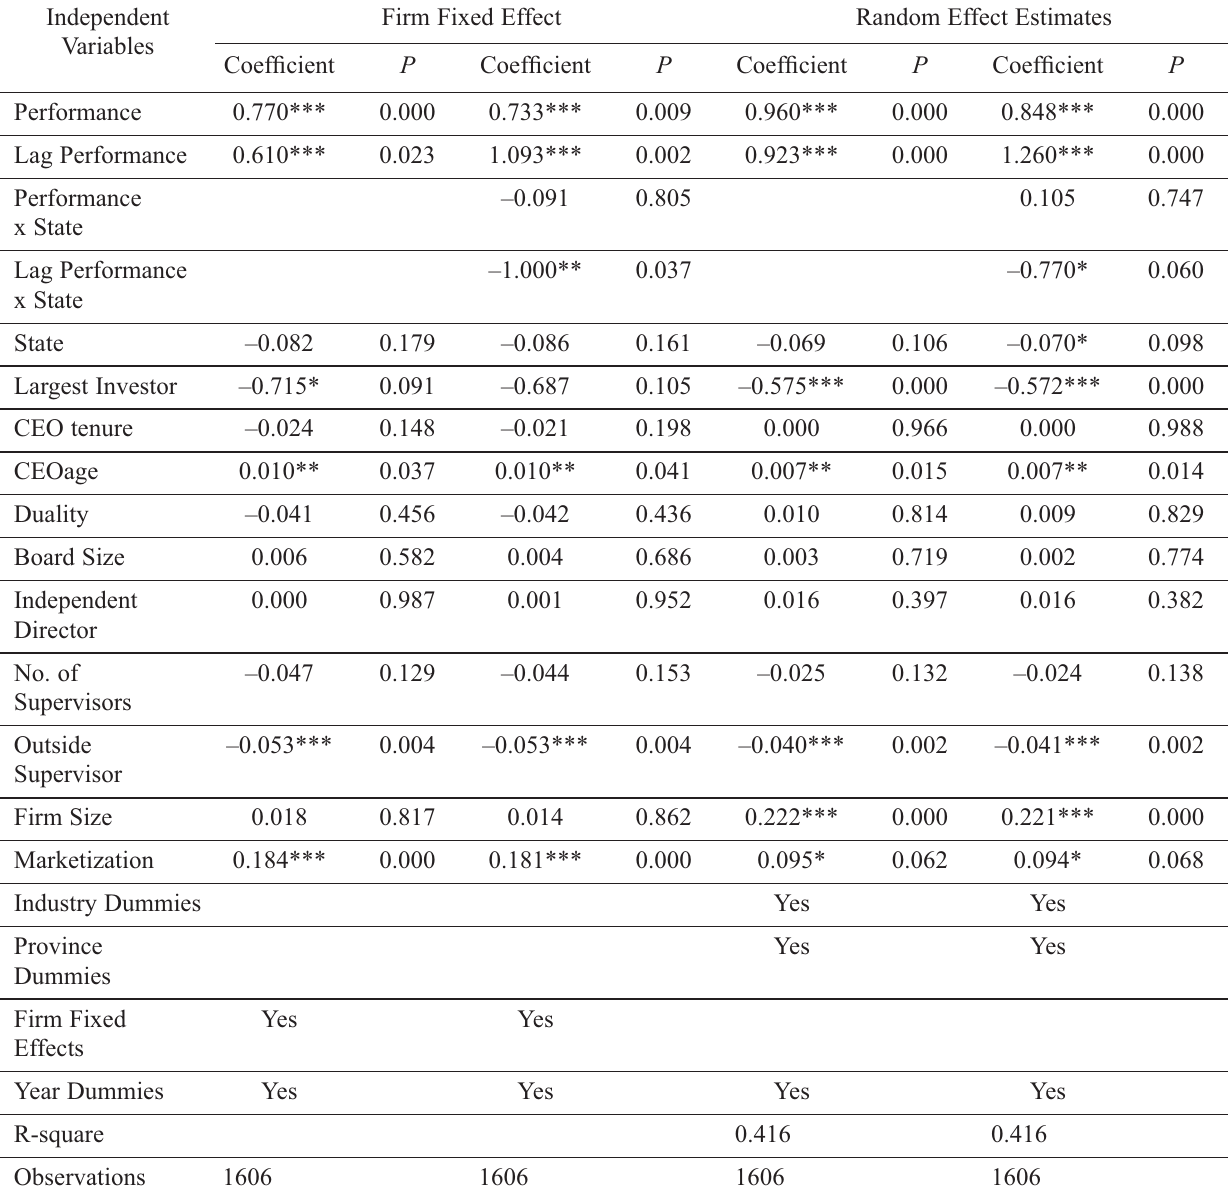
Table 9. CEO compensation and RPE (relative performance evaluation) at China’s listed fi